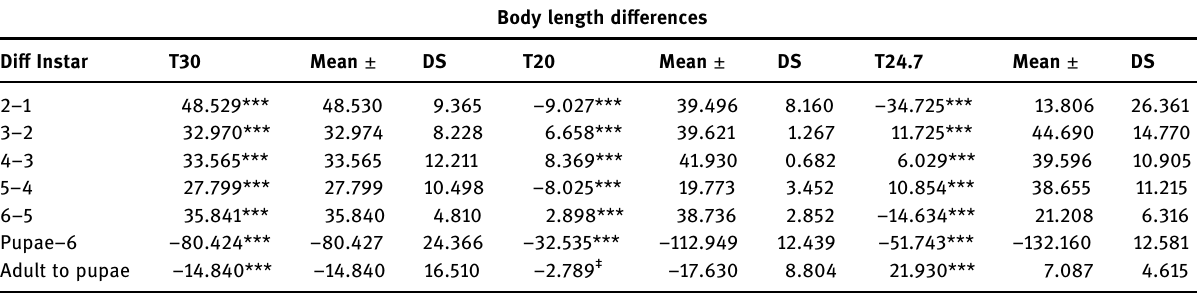
Table 5: Di ff erences in body length ( mm ) between each instar at di ff erent temperatures under controlled conditions for D. busckella Body length di ff